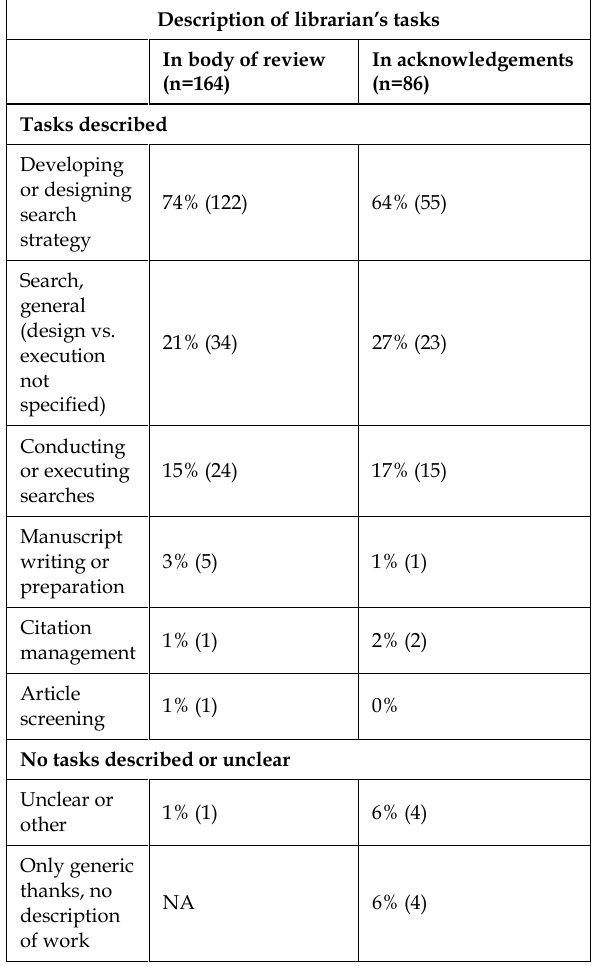
Table 3 Description of librarian’s